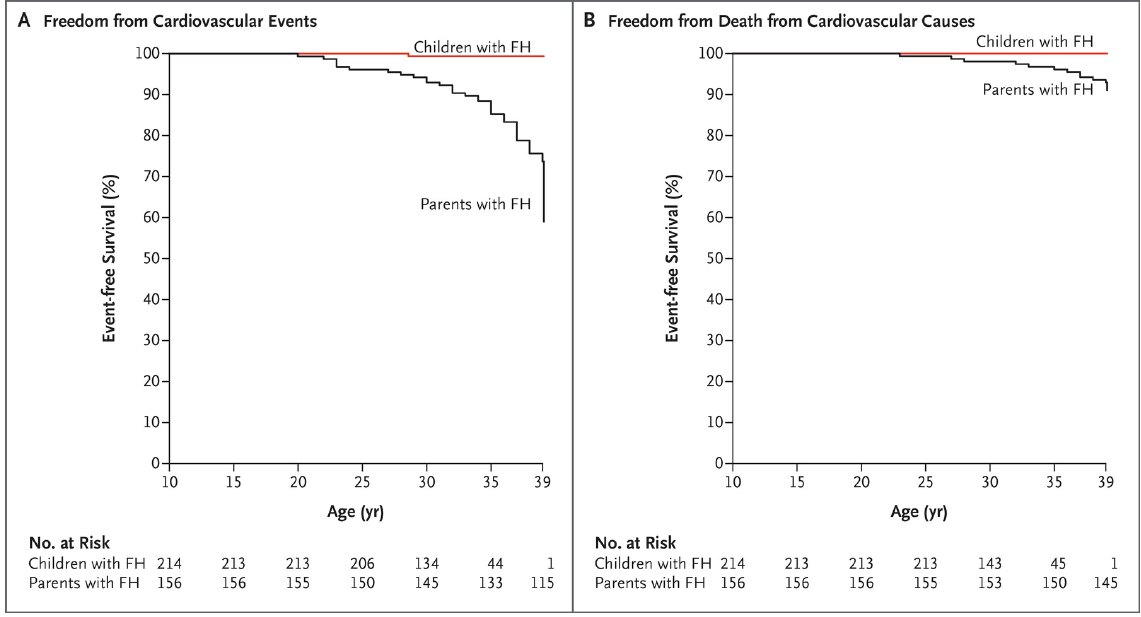
Figure 2. Kaplan–Meier curves for Patients with FH who began receiving statin therapy during childhood and their affected parents for whom statins were available much later in life. ( A ) Freedom from cardiovascular events; ( B ) freedom from death from cardiovascular causes [17].